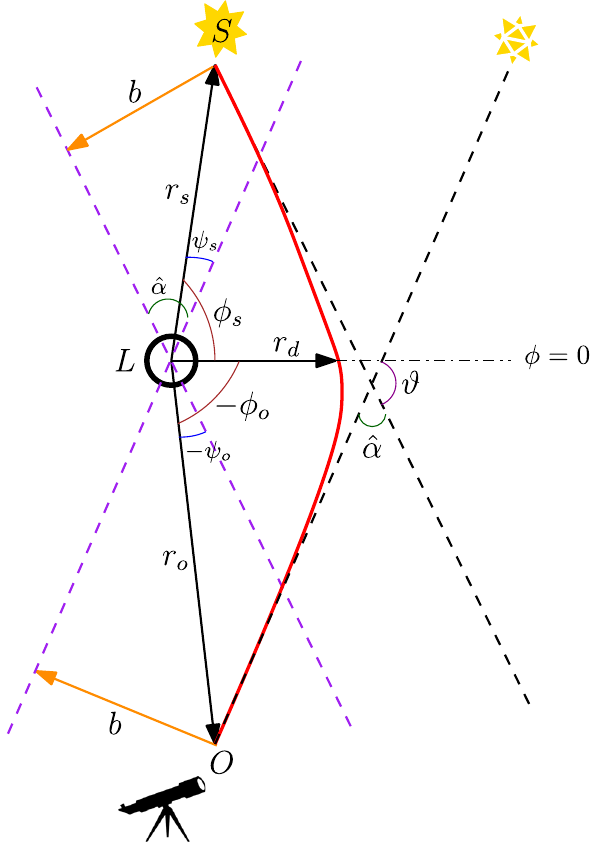
Fig. 6 Aschematicillustrationofthelensingphenomena.Theshortest distance r d to the lens L , has been taken to be the turning point in the OFK, lying on the φ = 0 line. The source and the observer are located at S ( r s ,φ s , b ) and O ( r o ,φ o , b )